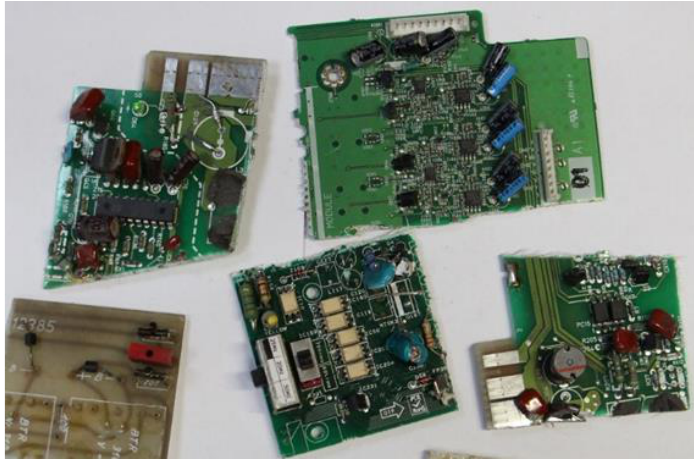
Figure 1. PCB scrap